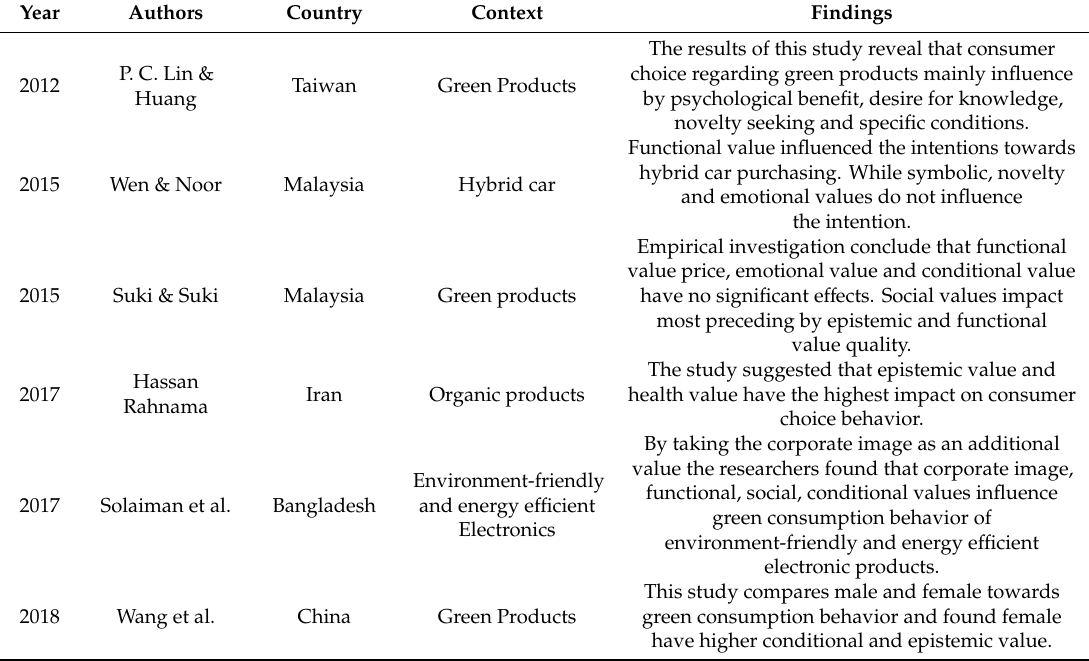
Table 1. Theory of consumption values used in the green